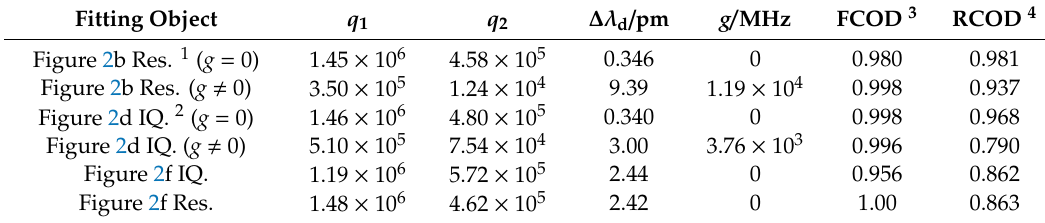
Table 1. Overlapping resonances fitting results.